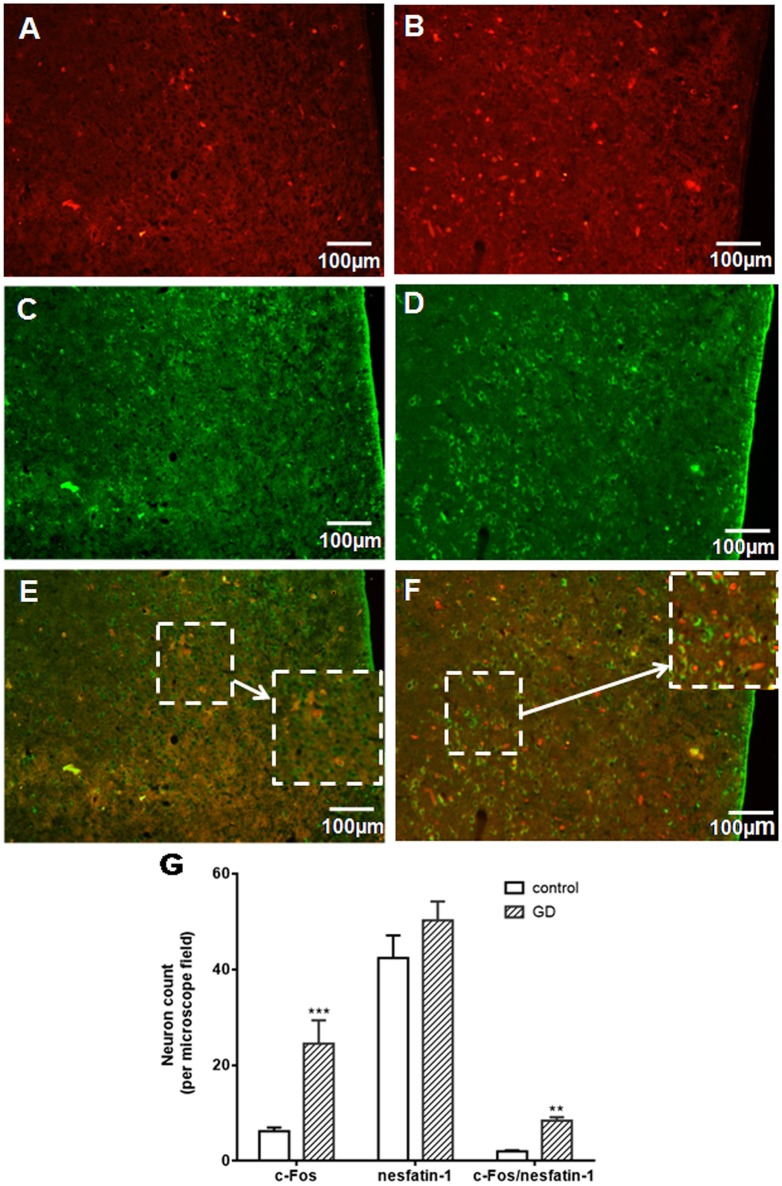
Effect of gastric distension on c-fos expression in NUCB2/nesfatin-1 positive neurons of VMH. (A,B) c-fos expression in the VMH in control (A) and rats following gastric distension (B). (C,D) Nesfatin-1 expression in the VMH in control (C) and rats following gastric distension (D). (E,F) Double immuno-detection of c-fos and NUCB2/nesfatin-1 in control (E) and rats following gastric distension (F). (G) Quantitative analysis of c-Fos, NUCB2/nesfatin-1, and co-expressing of c-Fos and NUCB2/nesfatin-1 in control and distended rats. **P < 0.01 vs. control; ***P < 0.001 vs. control. White arrow points to neurons co-expressing NUCB2/nesfatin-1 and c-fos.